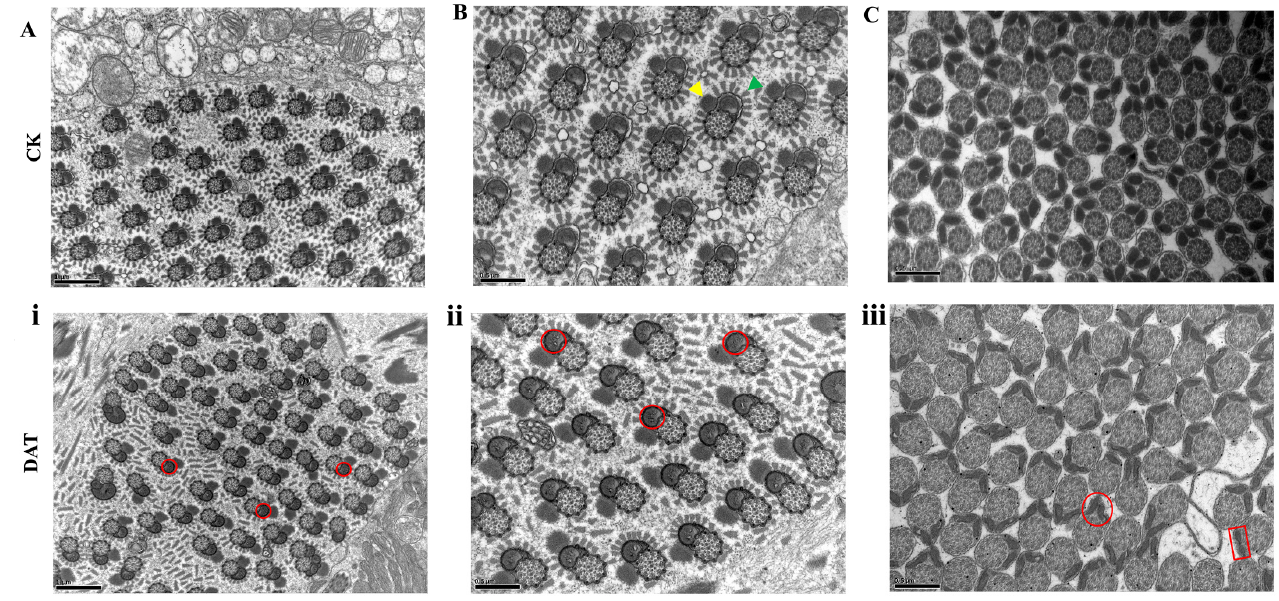
Figure 2. Transmission electron microscopy of S. cerealella apyrene and eupyrene sperm cells. ( A , B ) Transverse sections of the anterior region of eupyrene sperm bundles in testes of control moths. Yellow arrowhead indicates reticular appendage and green arrowhead shows lacinate appendage enlargement of ( i , ii ) cross-section of eupyrene sperm in testes of DAT-fumigated moth containing aberrant lines and malformed mitochondria (red circles). ( C ) Transverse sections of apyrene sperm bundles in testes of control adults. Control apyrene sperm show normal morphology of two mito- chondrial derivatives of apyrene sperm. The two mitochondrial derivatives indicate electron lucent end paracrystalline core and accessory tubules. ( iii ) Transverse section of apyrene spermatozoa in testes of DAT-fumigated adult moths. Red rectangular box and circle indicate abnormal and shrunken mitochondrial derivatives. The one end of mitochondrial derivatives indicates narrow peaks. The scale bars are shown in the lower left of the images. The scale bar for Figure A , i = 1 um and B , ii , C , iii = 0.5 um.